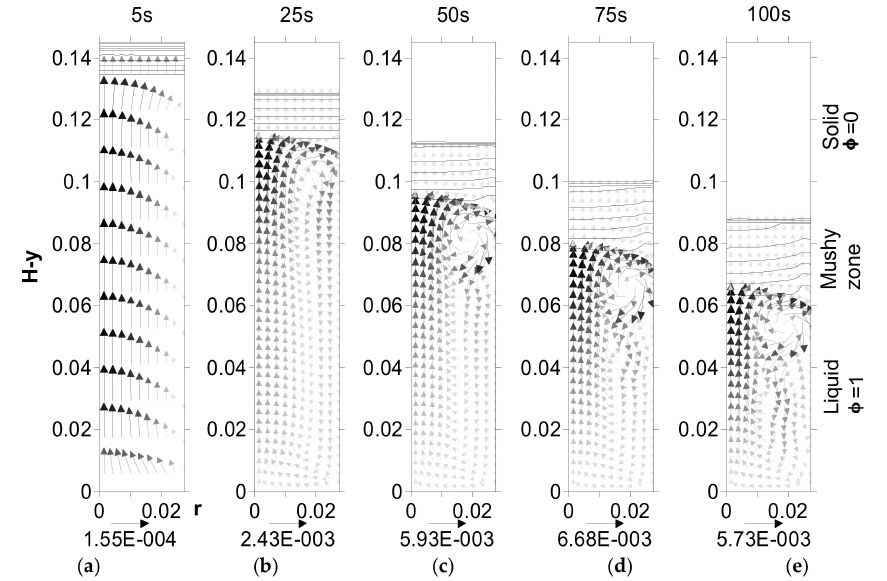
Figure 14. Development of fluid flow velocities (m.s − 1 ) during solidification for simulation S5 without effect of ∆ T for t = ( a ) 5 s; ( b ) 25 s; ( c ) 50 s; ( d ) 75 s; and ( e ) 100 s. The magnitudes of maximum velocities are presented at the bottom of ( a – e